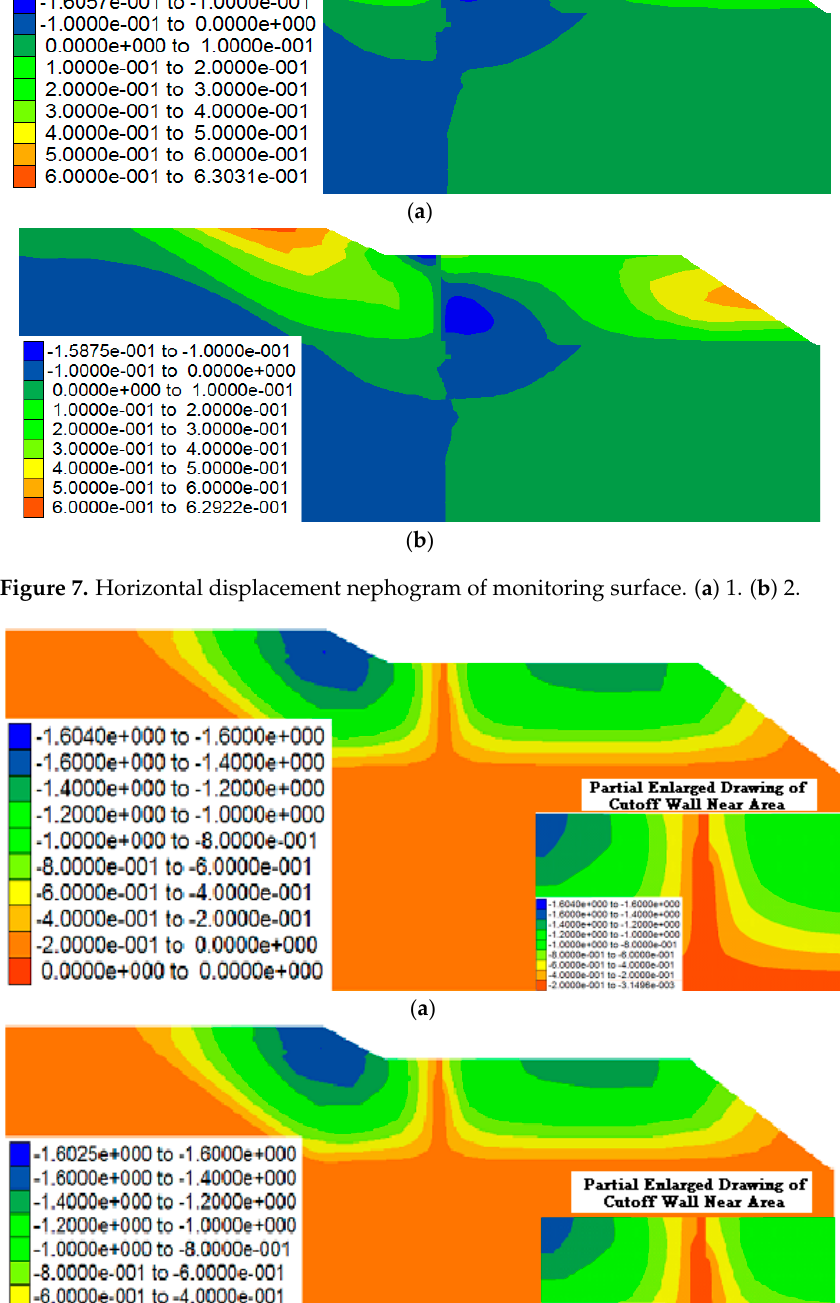
Figure 6. Cloud map of deformation law in analysis area of cut-off wall. ( a )Analysis Domain Hori- zontal Displacement Contour. ( b )Analysis domain vertical displacement cloud map. ( c ) Analyzing Domain and Displacement Contour.